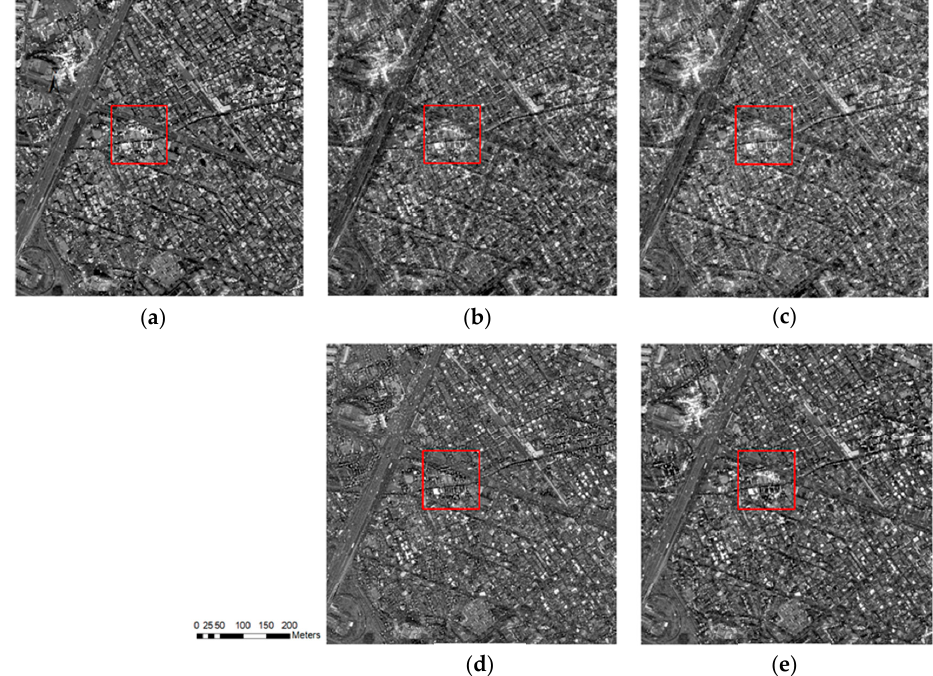
Figure 7. Comparison with the results of image fusion for Site 2: ( a ) proposed method; ( b ) a-trous wavelet decomposition; ( c ) discrete wavelet transform; ( d ) non-subsampled contourlet transform; and ( e ) non-subsampled contourlet transform-pulse couple neural